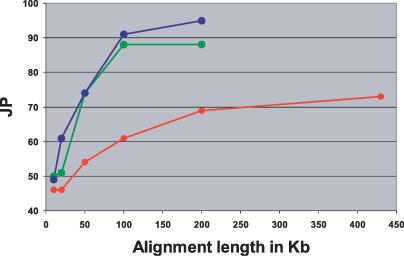
Jacknife Support for Exafroplacentalia Depending on the Alignment LengthRed, CNC; green, CDS_DNA; blue, CDS_AA.